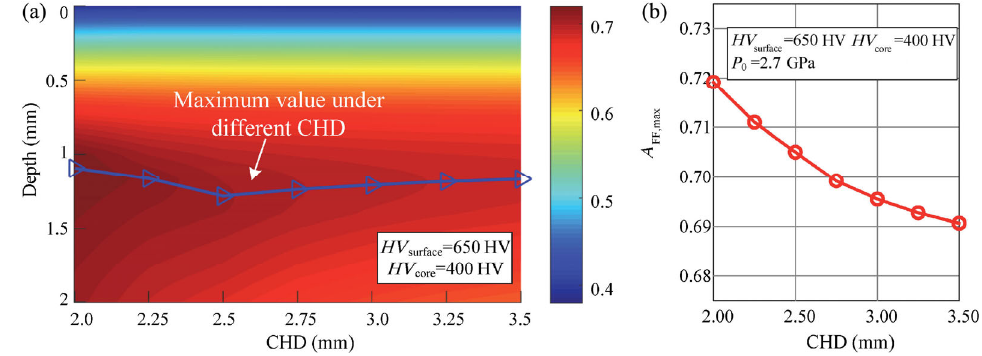
Fig. 14 Distribution of